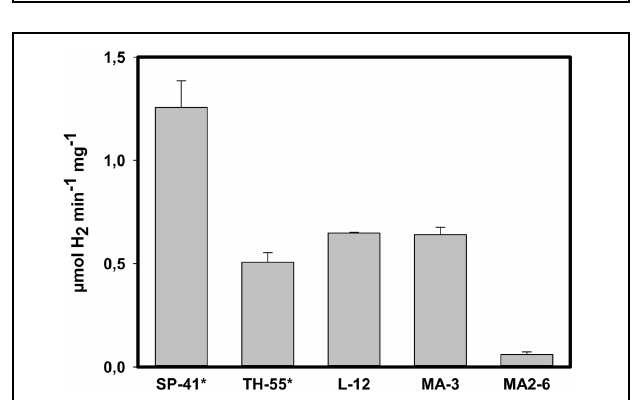
FIGURE 4 | Hydrogen uptake activity in partially purified proteins of the H